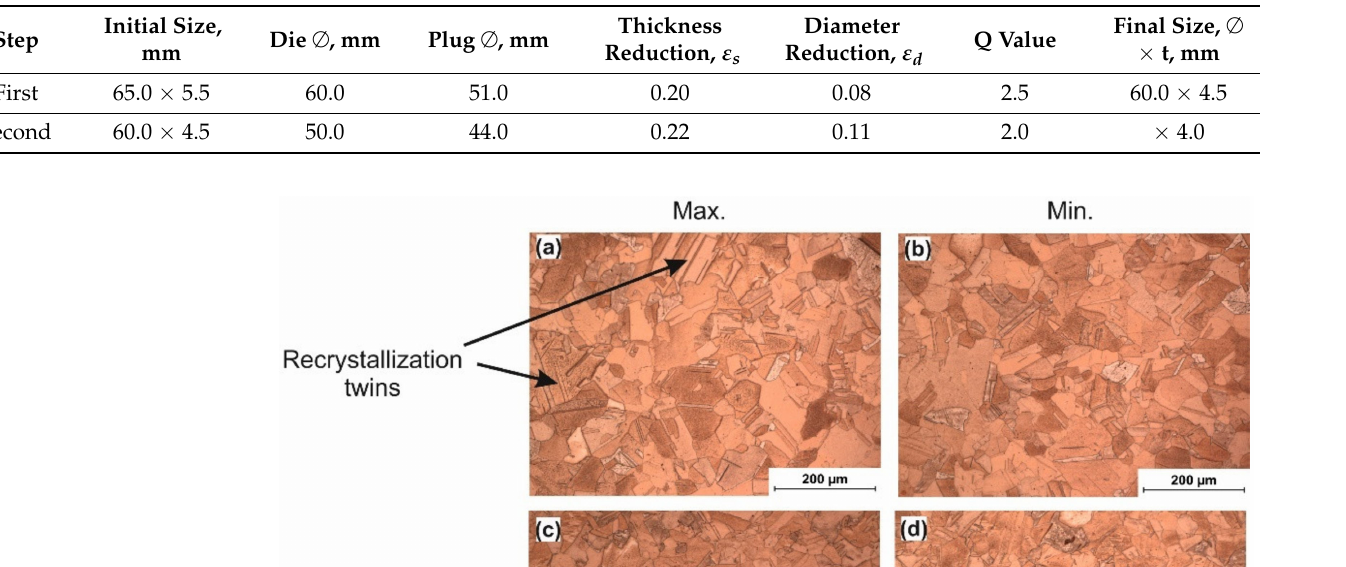
Table 1. Tube drawing process of Cu tubes.